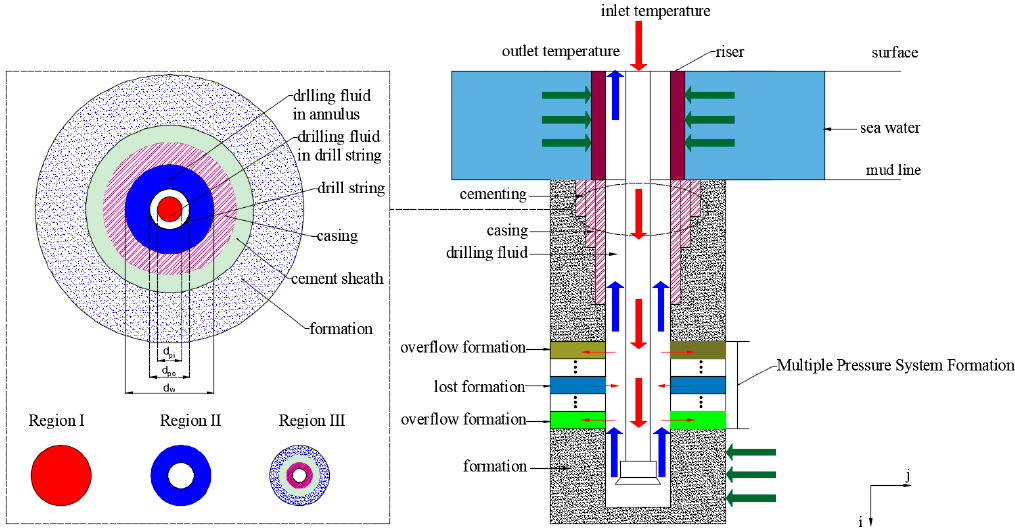
Figure 1. Heat transfer model of wellbore and formation under multi-pressure system.